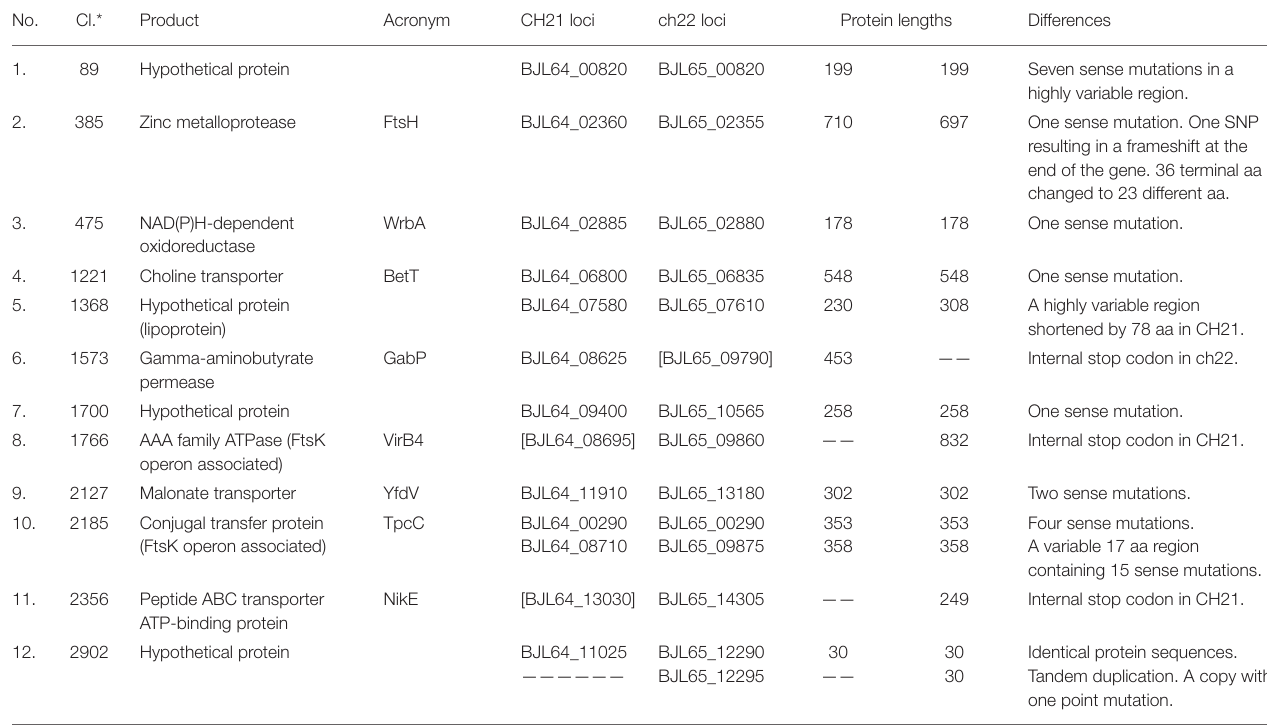
TABLE 3 | Identified differences in genes exclusively found between the VIR CH21 and NVIR ch22 strains. No.